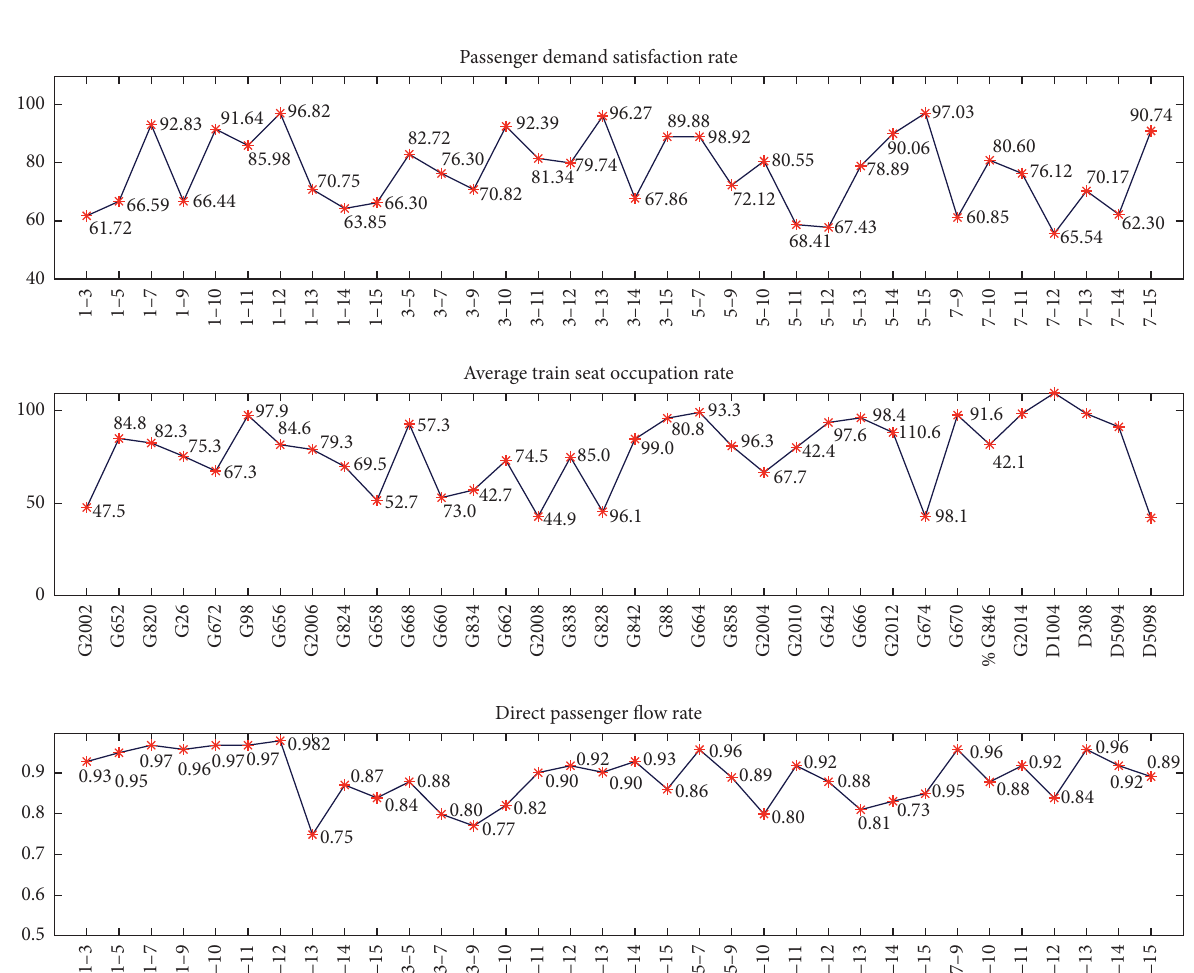
Figure 6: Related index value based on passenger flow intervals dividing simulation (by summer vacation in 2014).